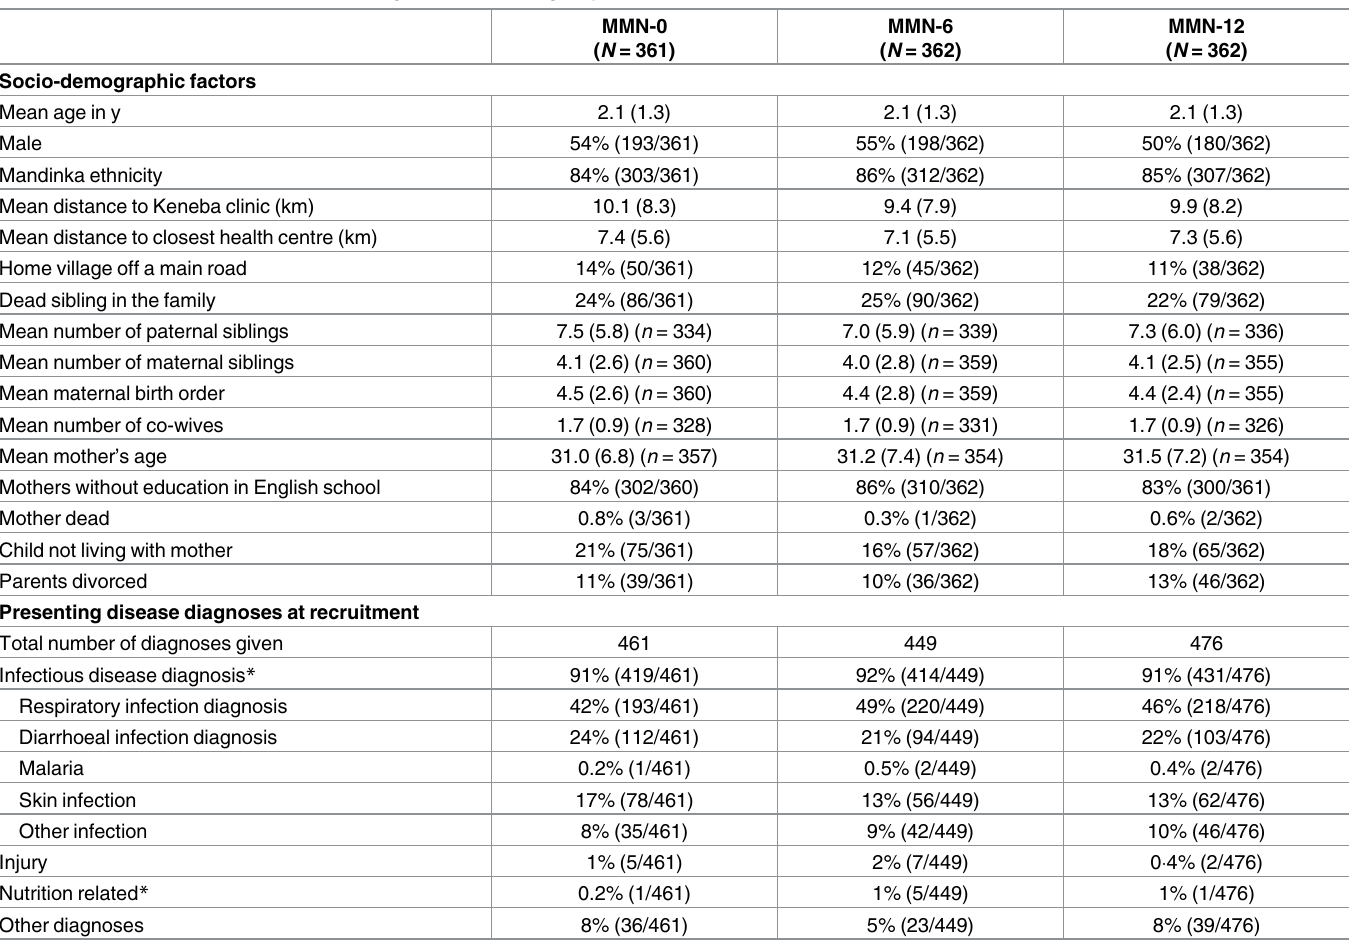
Table 1. Baseline characteristics according to randomised